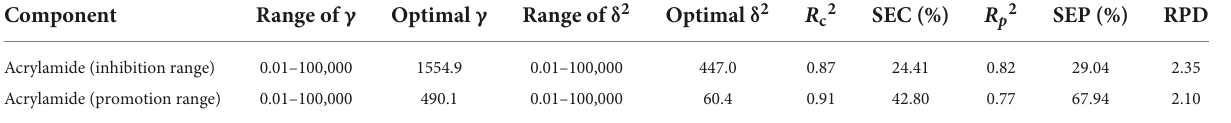
TABLE 1 Results of LS-SVR models for predicting acrylamide concentrations based on antioxidant properties.